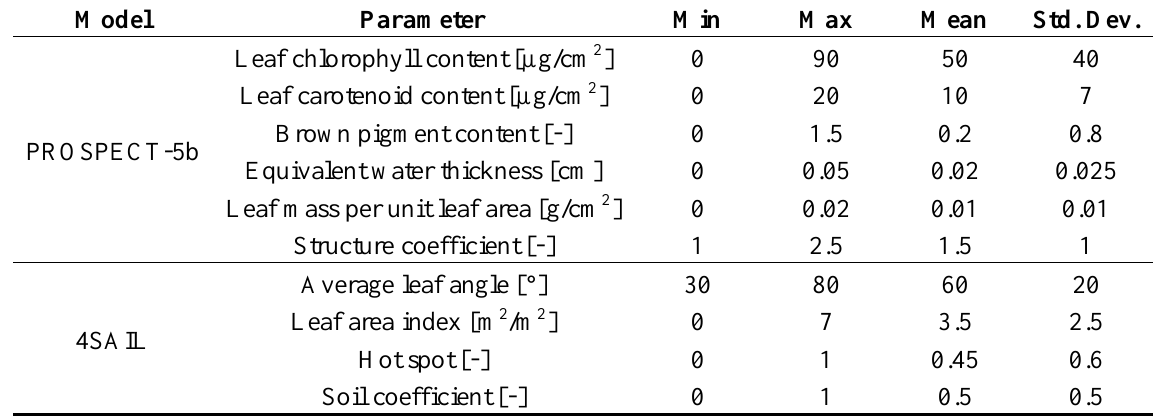
Table 2. Distribution of PROSAIL input parameters for the generation of the